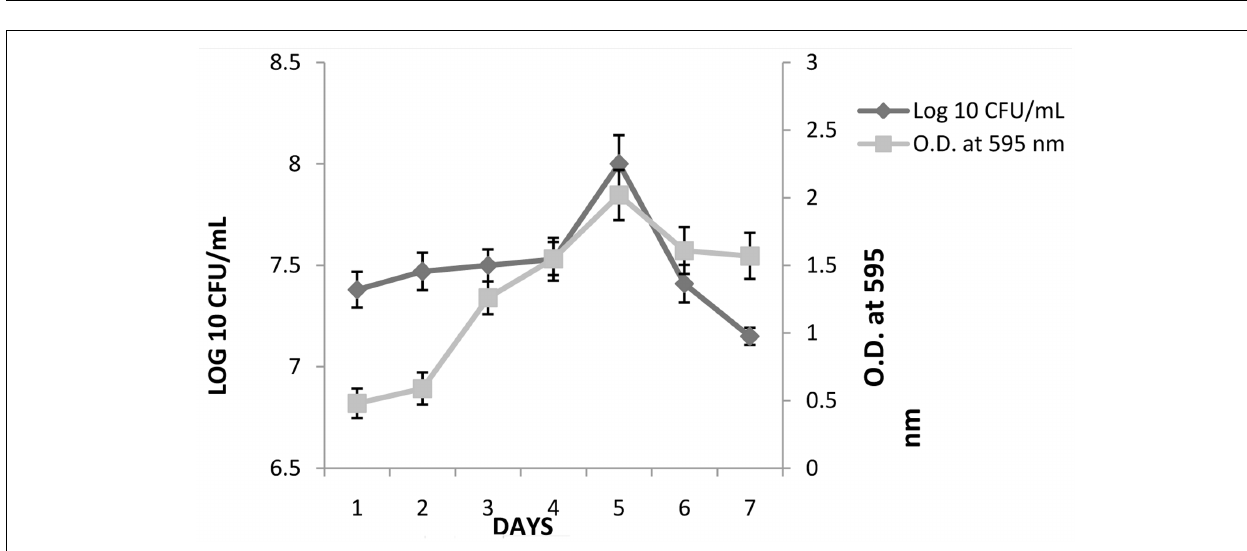
FIGURE 2 | Biofilm formation by K. pneumoniae in the wells of 96-well micro titer plate under static conditions as determined by viable count and crystal violet (OD 595 ). The experiment was performed in duplicate and repeated at least three times on different days. Error bars represent the mean ± of standard